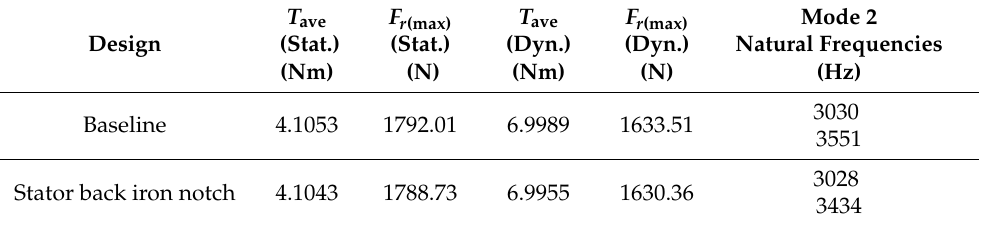
Table 9. Performance comparison for the baseline and stator back iron notch designs.